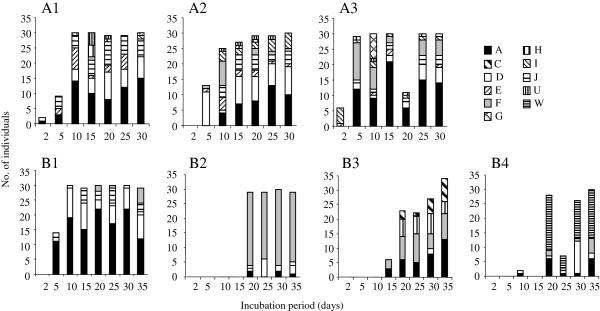
Genetics of colonizing Litoditis marina. MtDNA haplotype composition of the developing L. marina populations during the course of the experiment for each patch separately. A1A3 refer to the three patches in site A that were incubated amidst permanent Fucus stands, while B1B4 refer to the four patches in site B that were incubated in the absence of permanent algal stands. Distance between algal deposits within a site averaged 2 m, while site A and B were approximately 2 km apart. A-W represent different haplotypes. Note the late colonization and the low number of haplotypes of patches B2-B4, and the dominance of different haplotypes among B1-B4 (Figure from [48]).